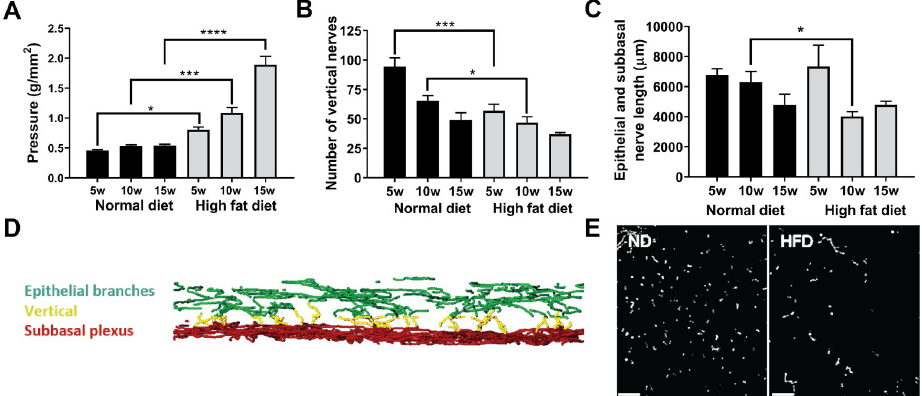
Fig 1. Changes in corneal nerves and sensitivity with HFD. C57BL/6 male mice were fed the ND or HFD for up to 15 weeks. (A) Cochet-Bonnett aesthesiometry was used to assess corneal sensitivity to touch before corneas were collected at 5, 10 or 15 weeks of feeding for corneal nerve analysis. Sensitivity is shown as the pressure necessary to induce a blink response (g/mm 2 ) (n = 28 ND, n = 35 HFD), (B) Morphometric analysis of the number of vertical nerves was determined by examining full thickness z-stacks of the epithelium (n = 12 ND, n = 13 HFD), (C) Analysis of the total length ( μ m) of epithelial nerves (epithelial branches and subbasal plexus) (n = 10 ND, n = 11 HFD), (D) Three-dimensional reconstruction of the epithelial nerves showing the subbasal plexus (red), epithelial nerve branches (green) and the vertical nerves (yellow) extending between them, and (E) en fa ce projected image of the region of the epithelium containing vertical nerves (anti- β tubulin III, scale bar = 30 μ m). Data shown as means ± SEM. � p < 0.05, ��� p < 0.001, ���� p <